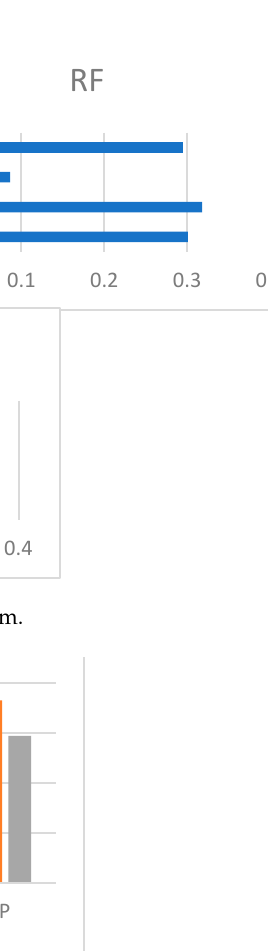
Figure 6. Degree of significance of each variable with relation to individual ML algorithms.